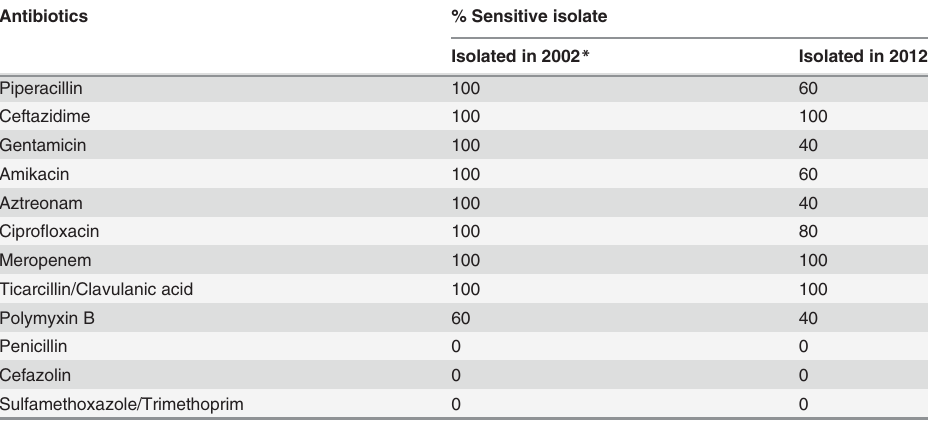
The content per antibiotics impregnated discs, 100 μ g of piperacillin, 30 μ g of ceftazidime, 10 μ g of gentamicin, 30 μ g of amikacin, 30 μ g of aztreonam, 50 μ g of cipro fl oxacin, 10 μ g of meropenem, 75/10 μ g of ticarcillin/clavulanic acid, 300IU of polymyxin B, 10IU of penicillin, 30 μ g of cefazolin, 23.75/1.25 μ g of